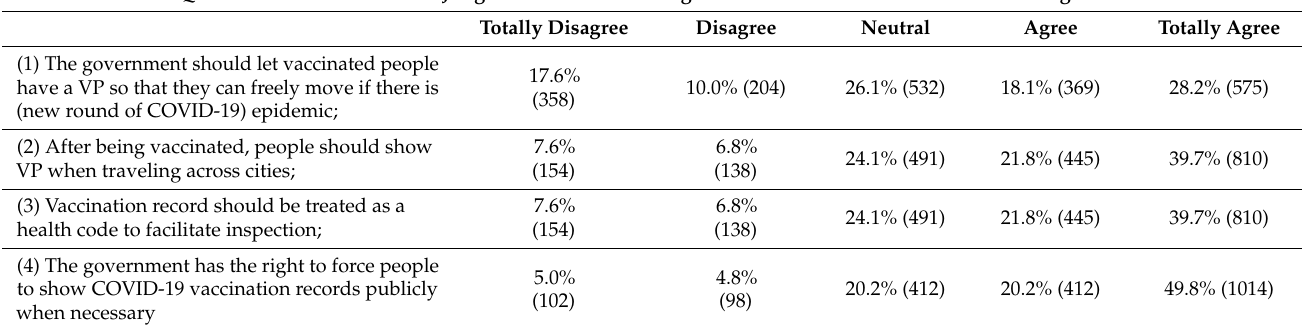
Table 2. Participants’ attitudes to VP ( n =